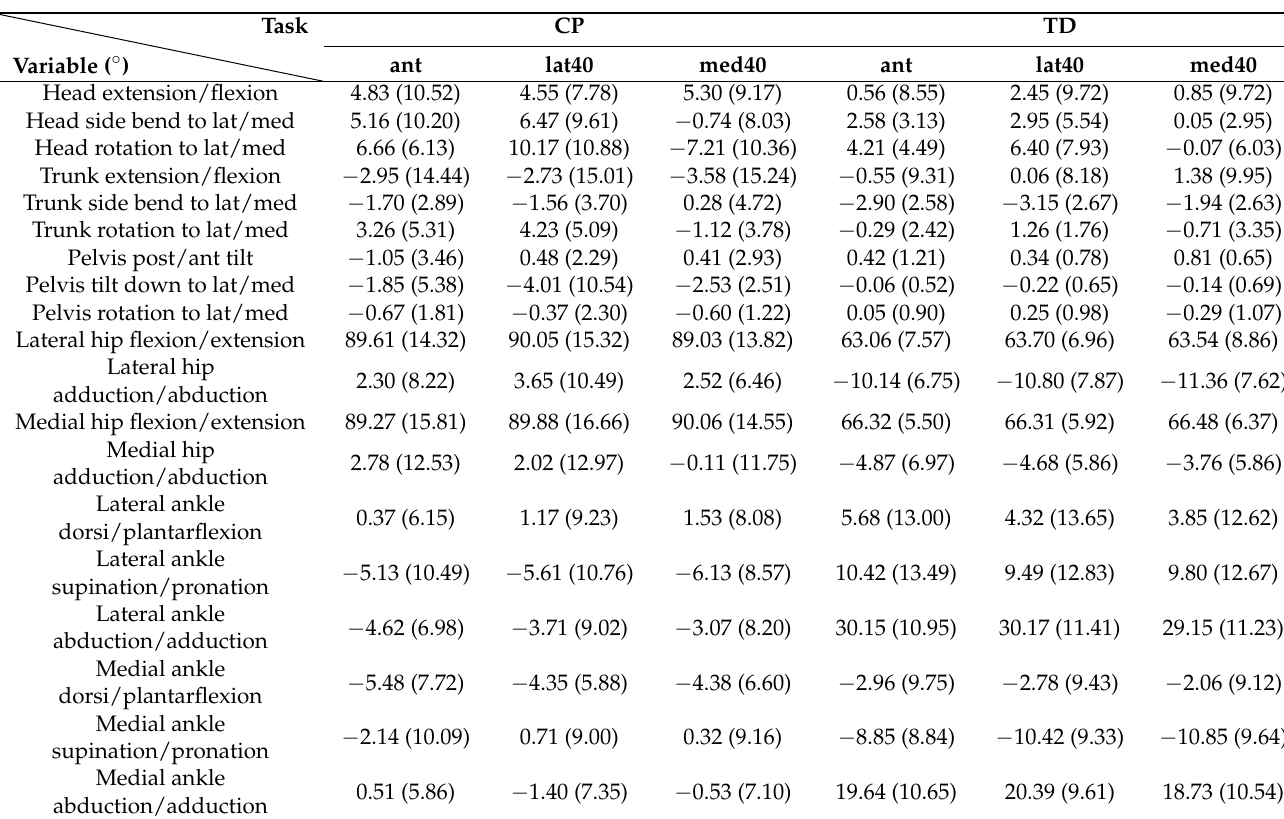
Table 1. Mean and standard deviation of dependent variables of postural alignment 300 ms before the preferred hand started to